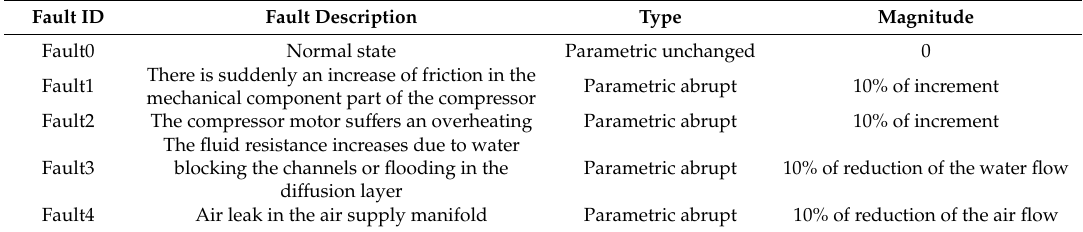
Figure 2. The PEM fuel cell system block diagram [1]. Table 2. Faults in the PEM fuel cell simulator model.